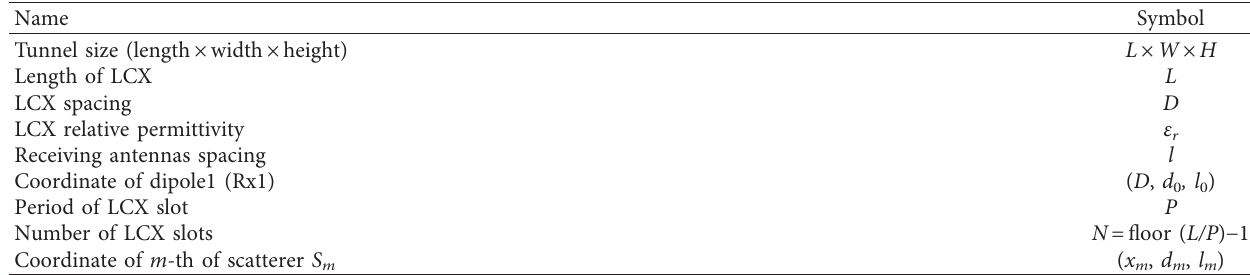
Figure 2: Projection view of the LCX-MIMO in a rectangular tunnel: (a) the front view; (b) the side view; (c) the top Table 1: Parameters name and symbol of LCX-MIMO channel model.